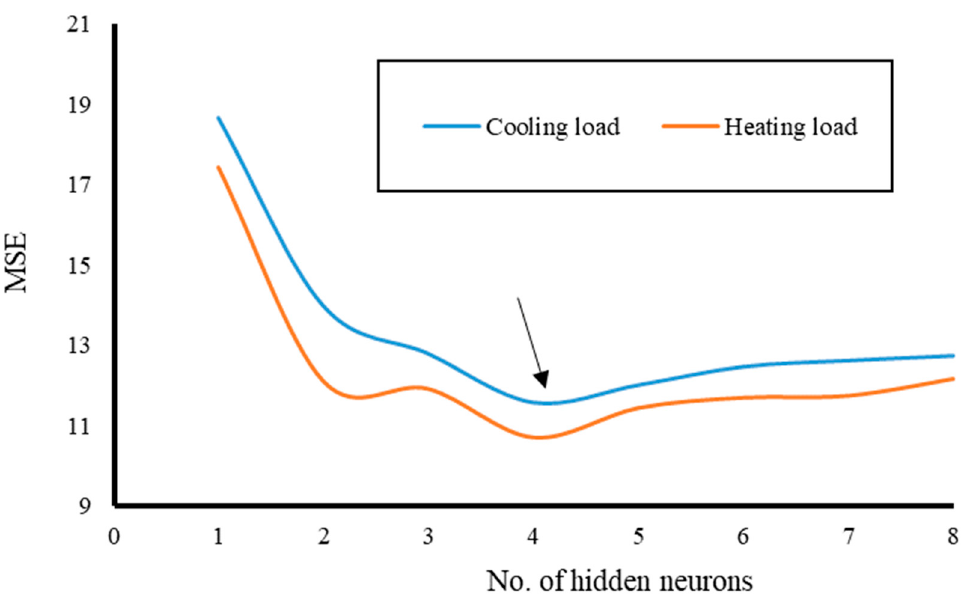
Figure 7. A sensitivity analysis for artificial neural network (ANN), based on the number of hidden neurons.